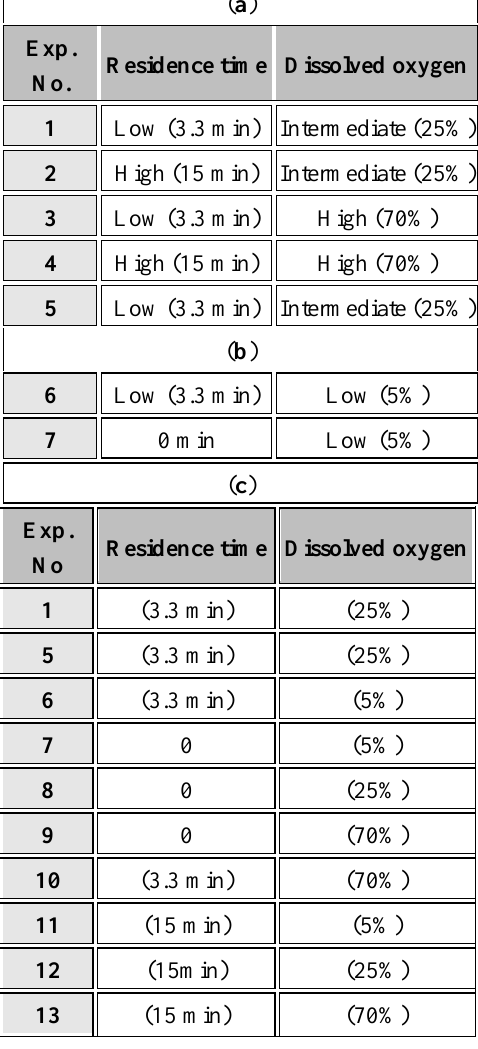
Table 1. ( a ) Full factorial design of experiments (DoE1) with the two qualitative factors (dissolved oxygen and residence time) in two levels (high and low levels for residence time, intermediate and high levels for dissolved oxygen). ( b ) Two additional experiments were performed for further analysis and comparison. ( c ) Full factorial design of experiments (DoE2) with two quantitative factors (residence time and dissolved oxygen) defined in three levels (0, 3.3 and 15 min for residence time and 5, 25 and 70% for dissolved oxygen). ( a )